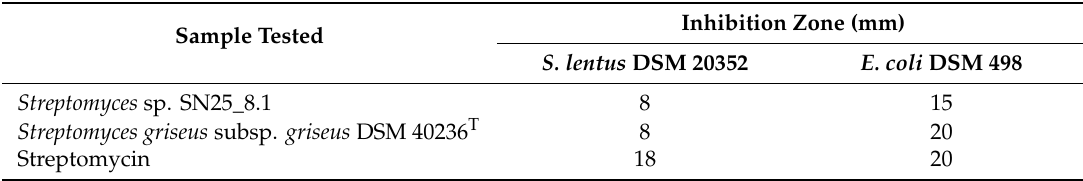
Table 1. Antibiotic activity of crude